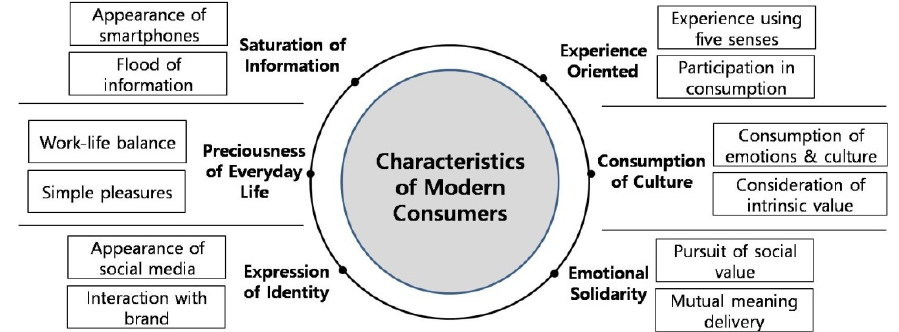
Figure 2. Characteristics of the modern consumer.